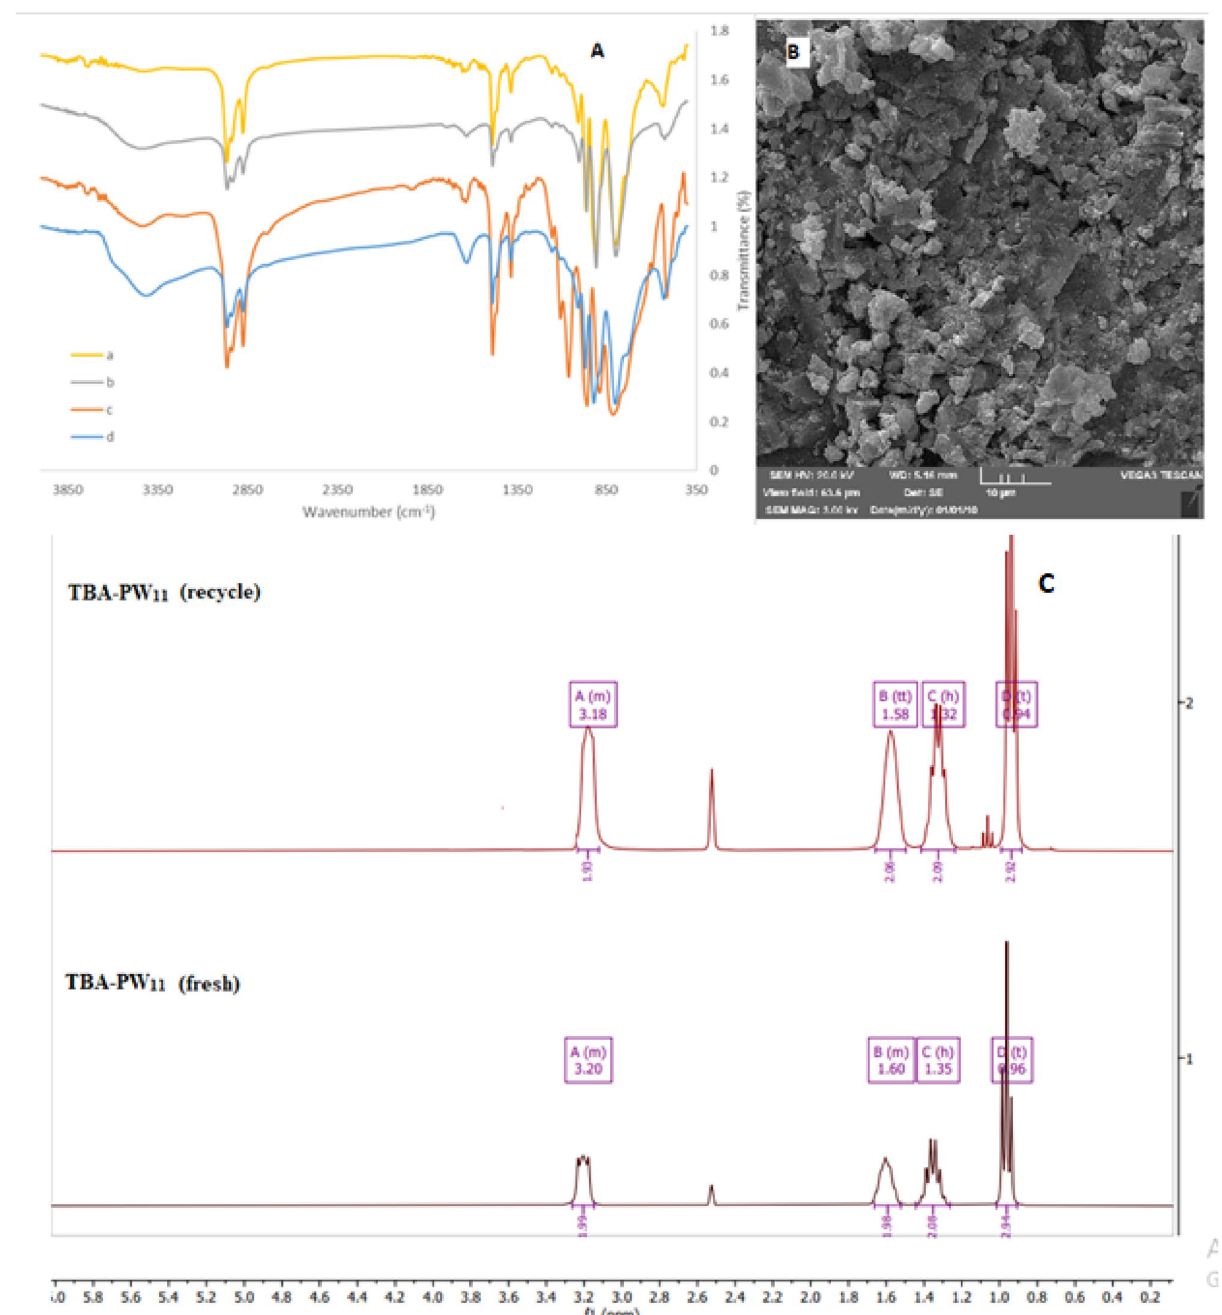
Figure 5. The FTIR analyses of the fresh and recycled TBA-PW 11 (a, b) and fresh and recycled TBA-SiW 11 (c, d) ( A ), respectively, SEM image of the recycled TBA-PW 11 ( B ) and the 1 HNMR spectra of the fresh and recycled TBA-PW 11 ( C